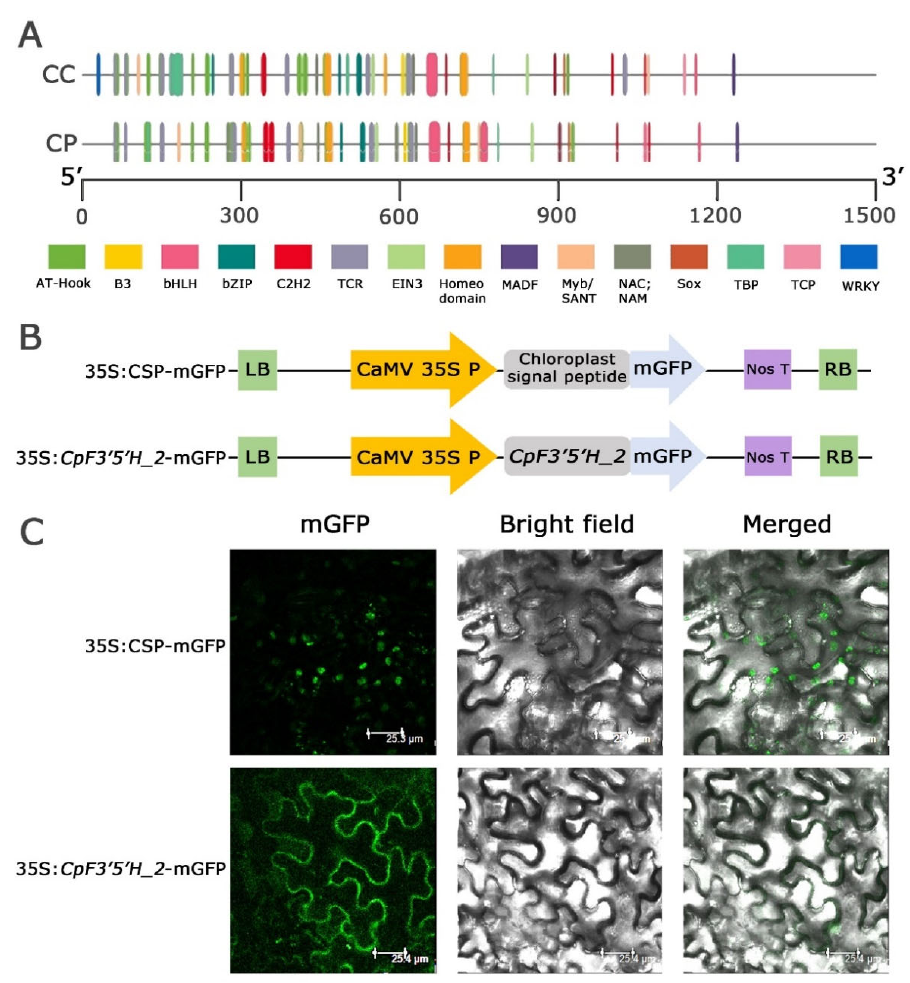
Figure 4. ( A ) Promoter analysis of F3 ′ 5 ′ H_2 gene in both the Cajanus spp. ( B , C ) Subcellular locali